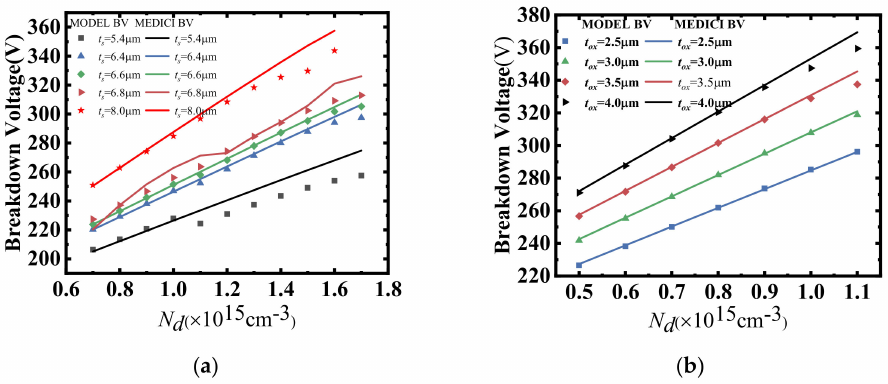
Figure 5. ( a ) Variation curves of BV with t s and N d for different t s at full depletion of the drift region. ( b ) Variation curves of BV with t ox as and N d for different t ox at full depletion of the drift